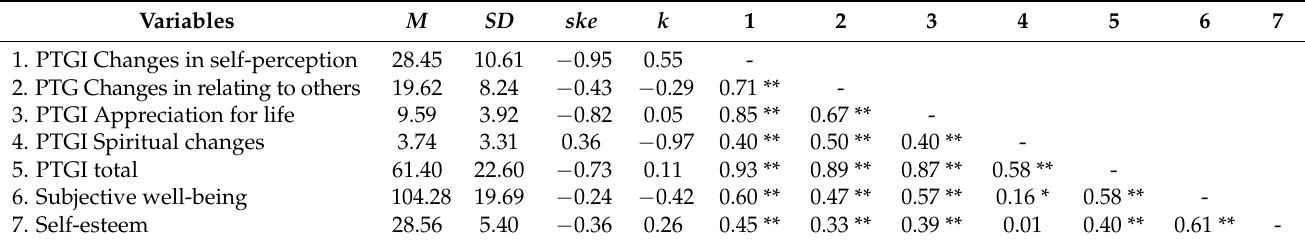
Table 1. Descriptive Statistics and Pearson’s Correlations between Posttraumatic Growth, Self-esteem, and Subjective